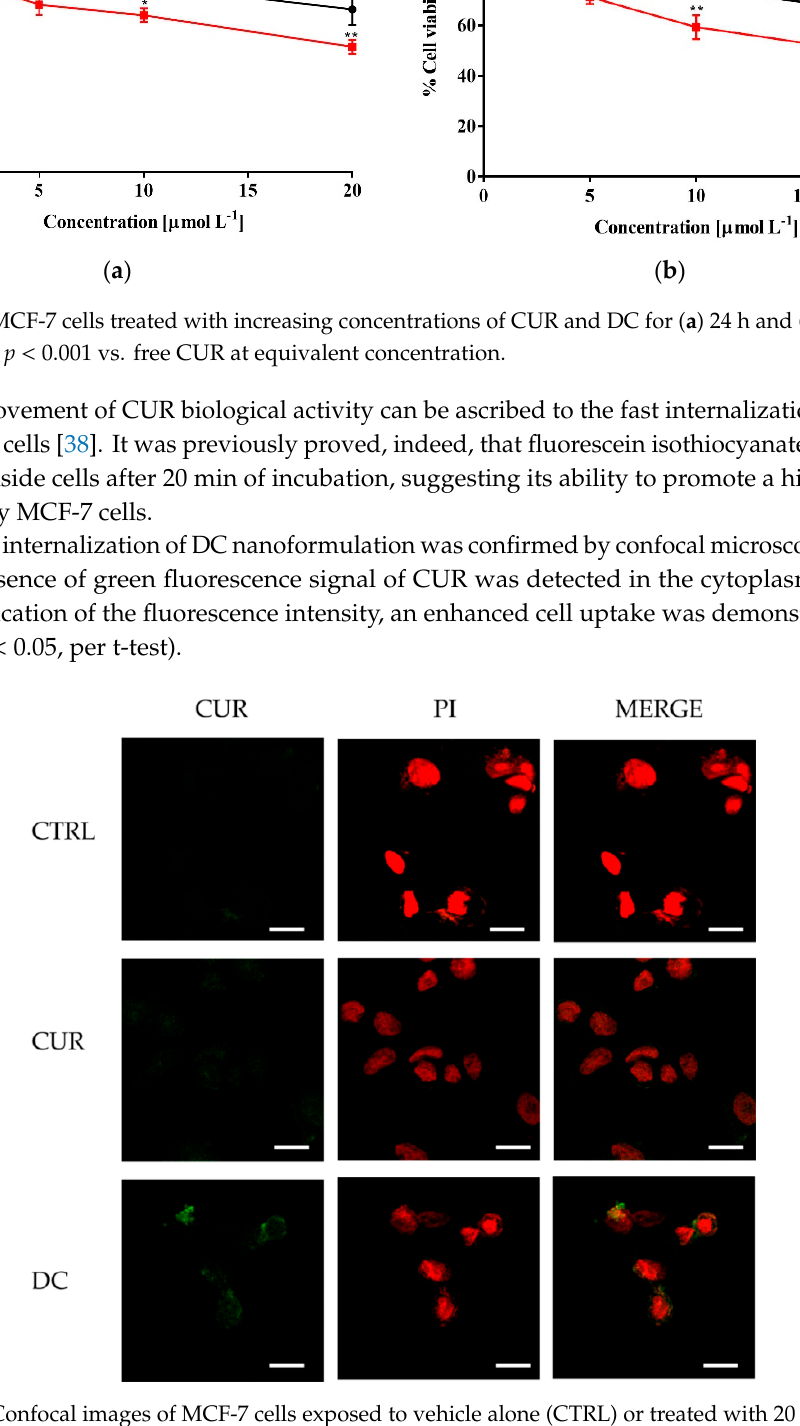
Figure 6. Confocal images of MCF-7 cells exposed to vehicle alone (CTRL) or treated with 20 µmol L − 1 of curcumin (CUR) or 20 µmol L − 1 of Dextran/curcumin (DEX/CUR) for 4 h. Scale bar: 20 µm.